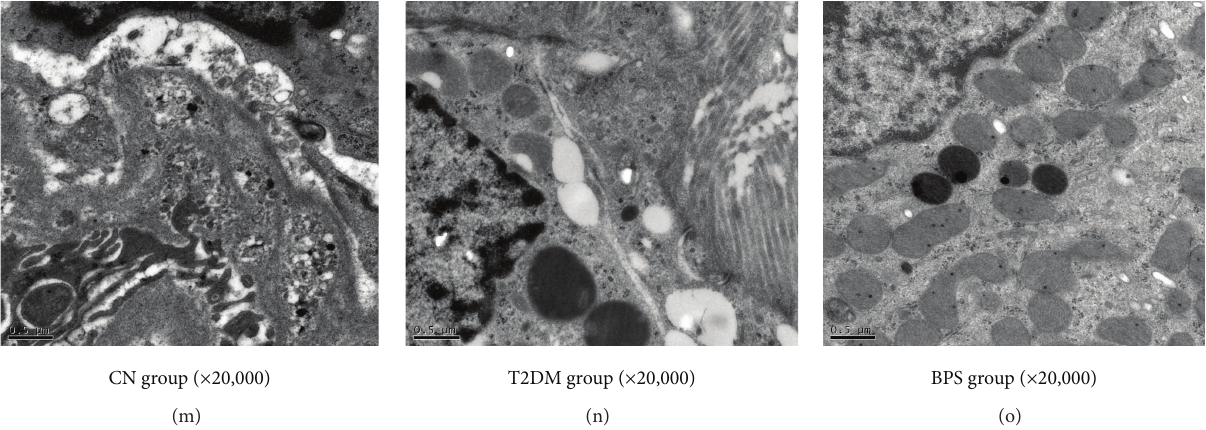
Figure 3: Effects of BPS on histopathology and ultrastructure of the kidney injury in HFD/STZ-induced diabetic rats. Table 5: HFD/STZ-induced inflammation-related parameters of rats in experiment ( 𝑛 = 6 , 𝑋 ± 𝑆 ). CN group T2DM